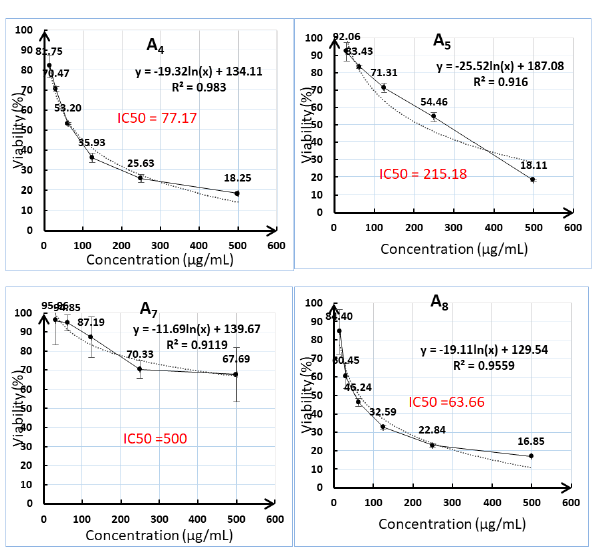
Fig. 1. The relationship of the percentage of inhibition with the concentration and calculate the (IC50) for the studied